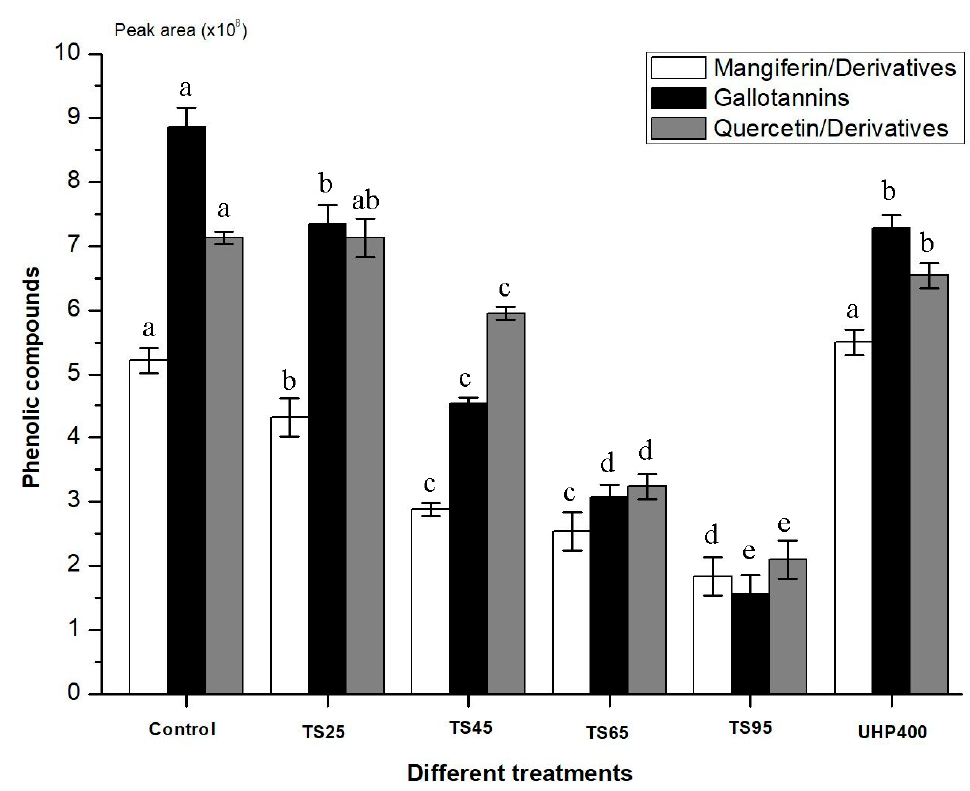
Figure 1. Effects of thermo-sonication (TS) and ultra-high pressure (UHP) on phenolic groups, mangiferin and its derivatives, quercetin derivatives and gallotannins. TS25, TS45, TS65 and TS95 represent thermo-sonication treatment at 25, 45, 65 and 95 °C. UHP400 represents ultra-high pressure at 400 MPa for 10 min. Each column represents a mean and the vertical bars indicate the standard deviation. Means with different letters within the same color columns are significantly different (LSD test, p < 0.05).